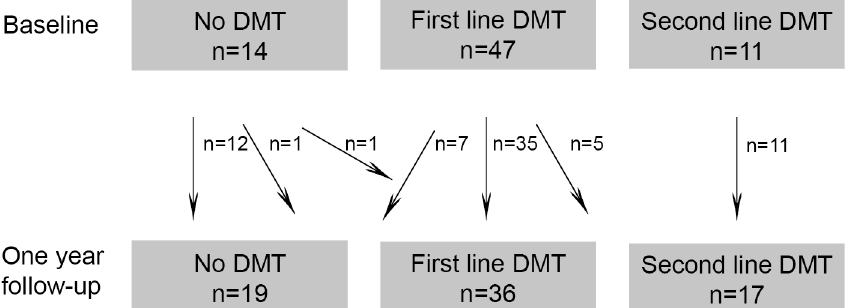
Fig 5. Patients in different treatment groups at baseline and follow-up. The arrows indicate change in treatment groups of patients from baseline to follow-up. Eight patients changed first line treatment during the period, not illustrated.